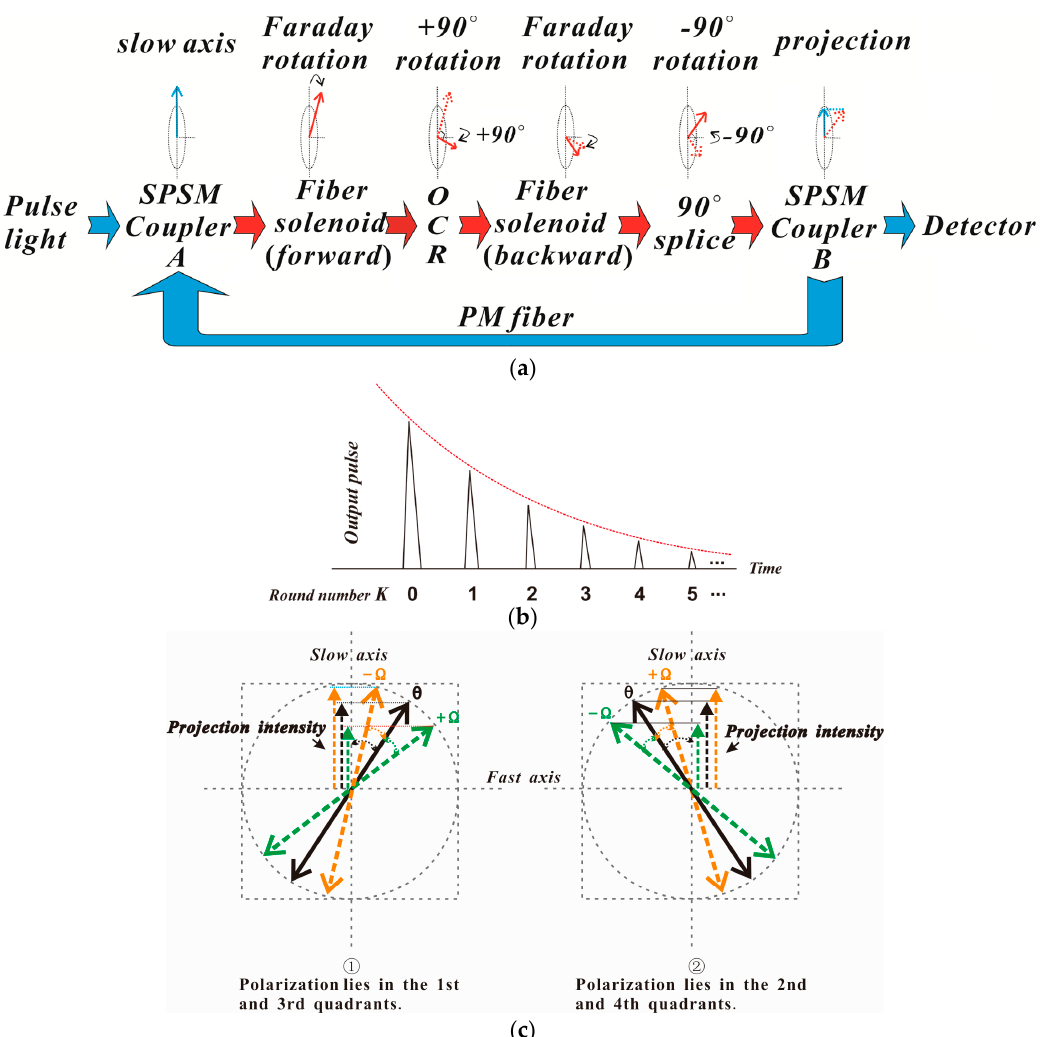
Figure 2. The changing process of light in the loop AFCS based on the SPSM coupler, ( a ) for the change of polarization state of light, ( b ) for the output signal, and ( c ) for the relationship between Faraday rotation angle Ω and the angle θ .